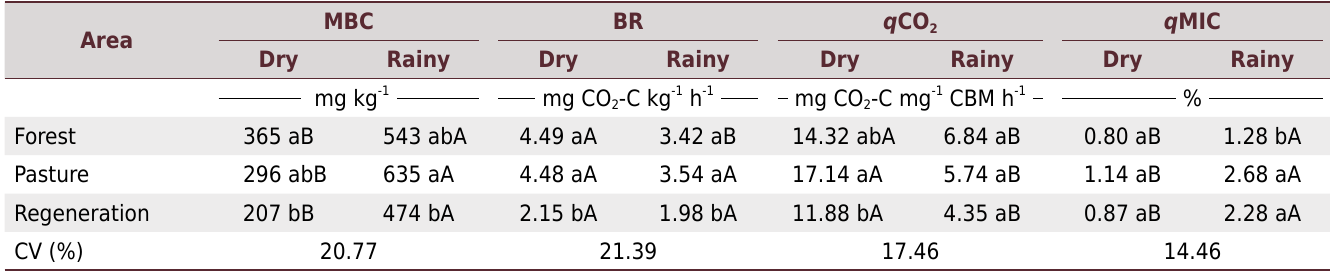
Table 3. Microbial biomass carbon (MBC), and activity (soil basal respiration - BR, metabolic quotient - q CO 2 , and microbial quotient - q MIC) in topsoil (0.00-0.05 m) sampled in the dry and rainy season in forest, pasture, and natural regeneration areas on the Palmital farm in Passa Vinte, MG, Brazil Area